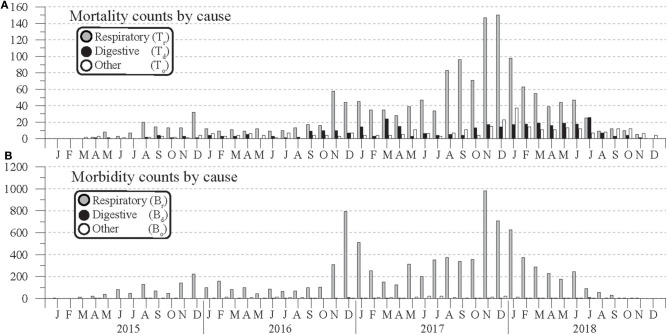
Monthly counts of (A) mortality and (B) morbidity by cause for cattle across 19 feedlots within a 96.6-km radius of Hereford, TX, in the Texas Panhandle from January 2015 to December 2018.